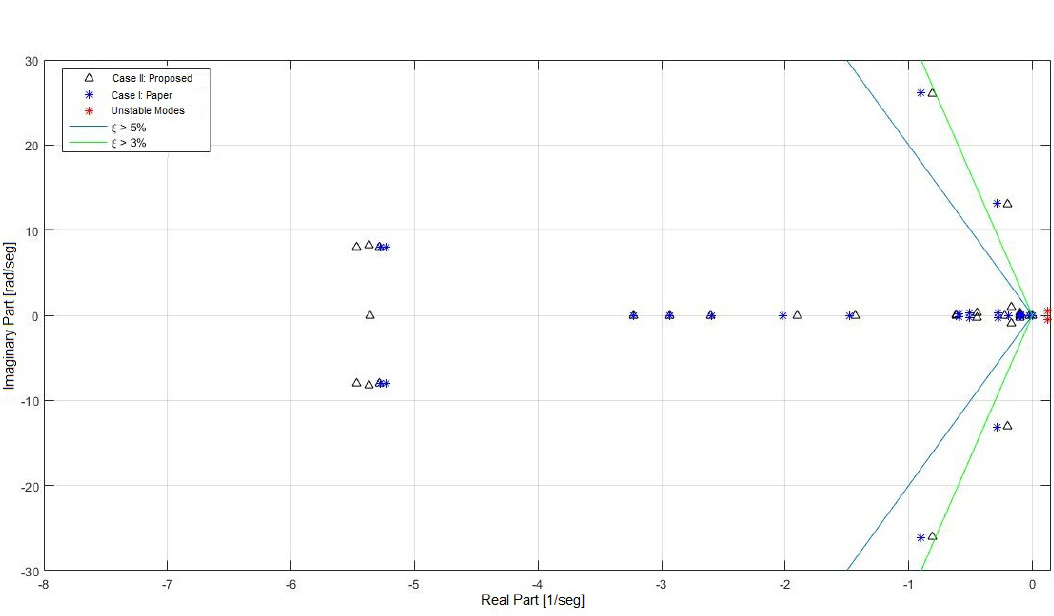
Figure 10. Eigenvalues system I.